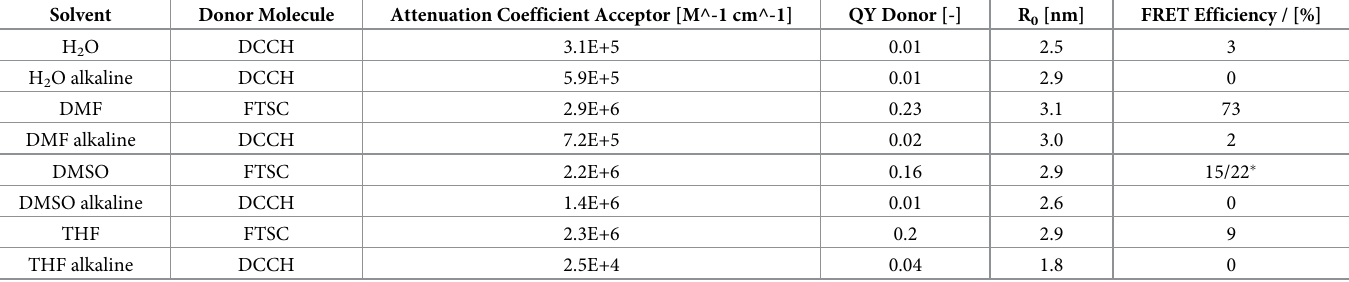
Table 3. Comparison between relevant parameters and the resulting Fret signal. The reported attenuation coefficient is the area under the measured curve and the pro- vided FRET efficiency stems from acceptor sensitation (Eq 4). The results for donor quenching can be found in the S1 File. Solvent Donor